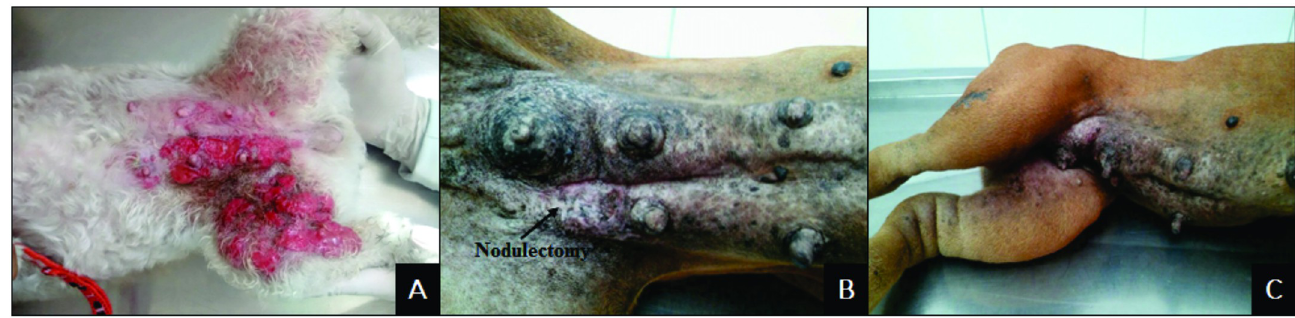
Fig 1. Macroscopic features of inflammatory mammary carcinoma in female dogs. A) Plaque-like growth in the left mammary chain extending to the inner face of the pelvic limb presenting diffuse erythema and containing extensive erosion and ulceration areas. B) Mammary chains with plaque growth after nodulectomy. C) Intense edema of the limbs.